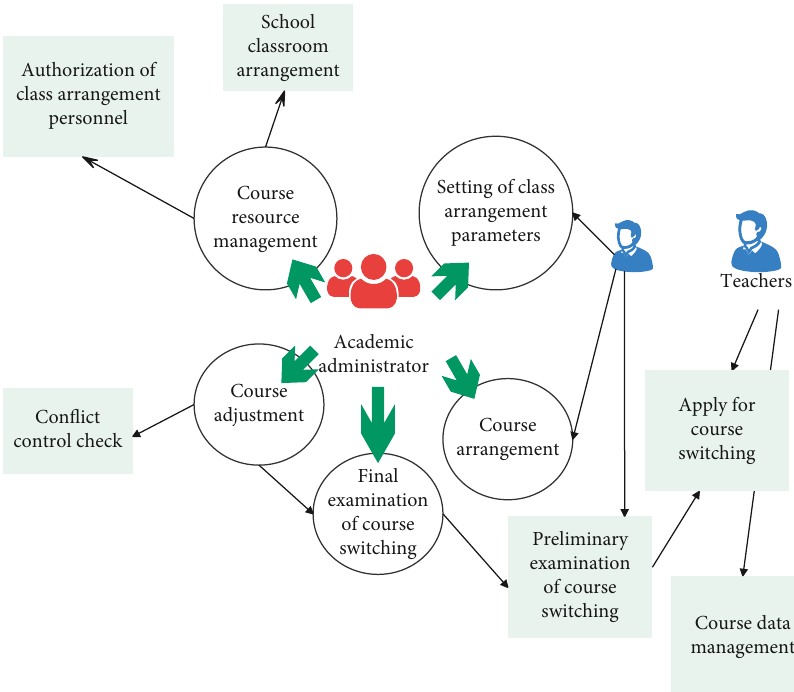
Figure 8: Use case diagram of course scheduling management module.